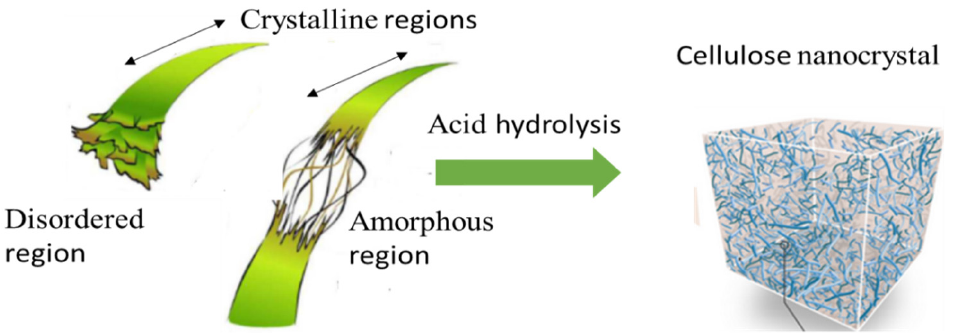
Figure 3. A schematic diagram of the reaction between cellulose and strong acid to obtain a nano- cellulose crystal (adapted and modified from Isogai et al [43]).